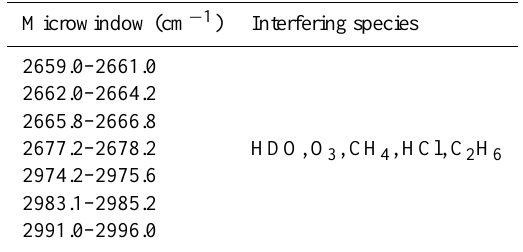
Table 1. The spectral microwindows used for retrieval of water vapour and the major interfering species